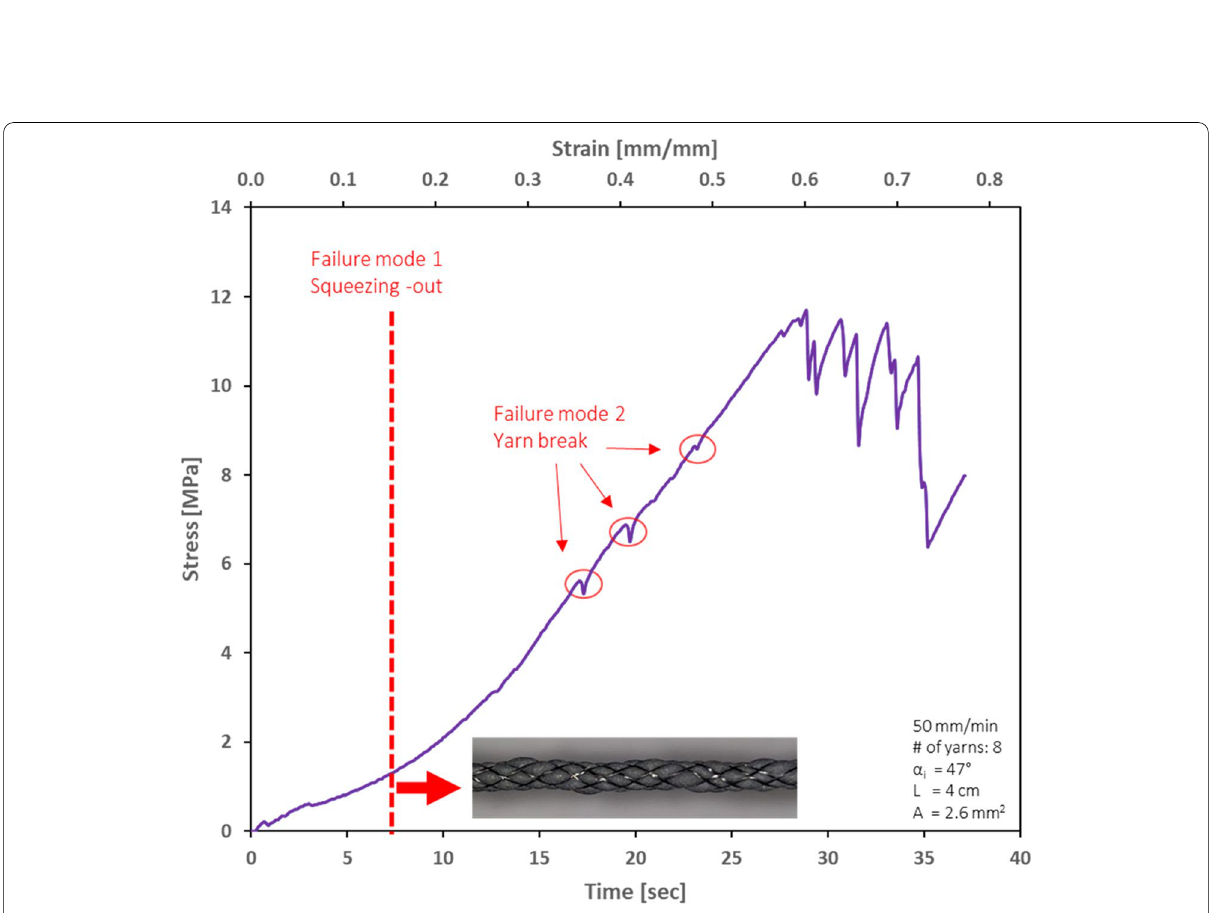
Fig. 9 Plot of stress versus time (bottom scale) and strain (upper